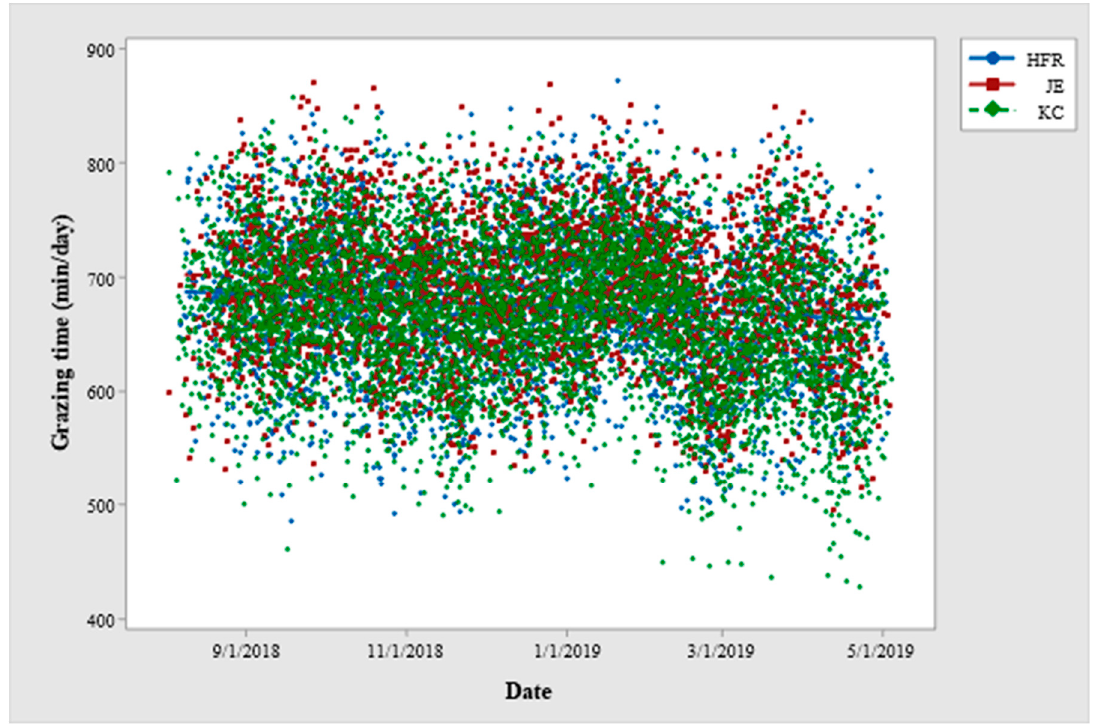
Figure 2. Scatterplot between date and grazing time (min/day) for Holstein-Friesian (HFR), Jersey (JE) and KiwiCross (KC) cows across the lactation period for Year-1 of the study period. (The scatterplot is based on the raw values of grazing time).